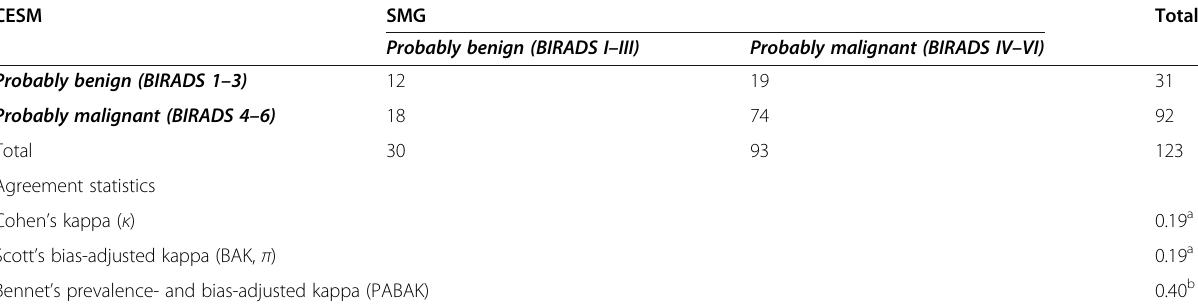
Table 13 Agreement between SMG and CESM regarding lesion classification as probably malignant or probably benign in the whole study population